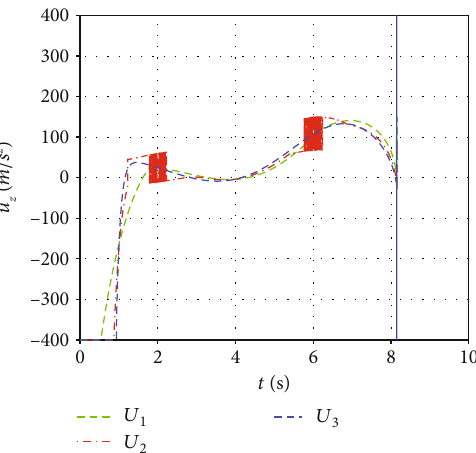
Figure 48: Acceleration instruction u